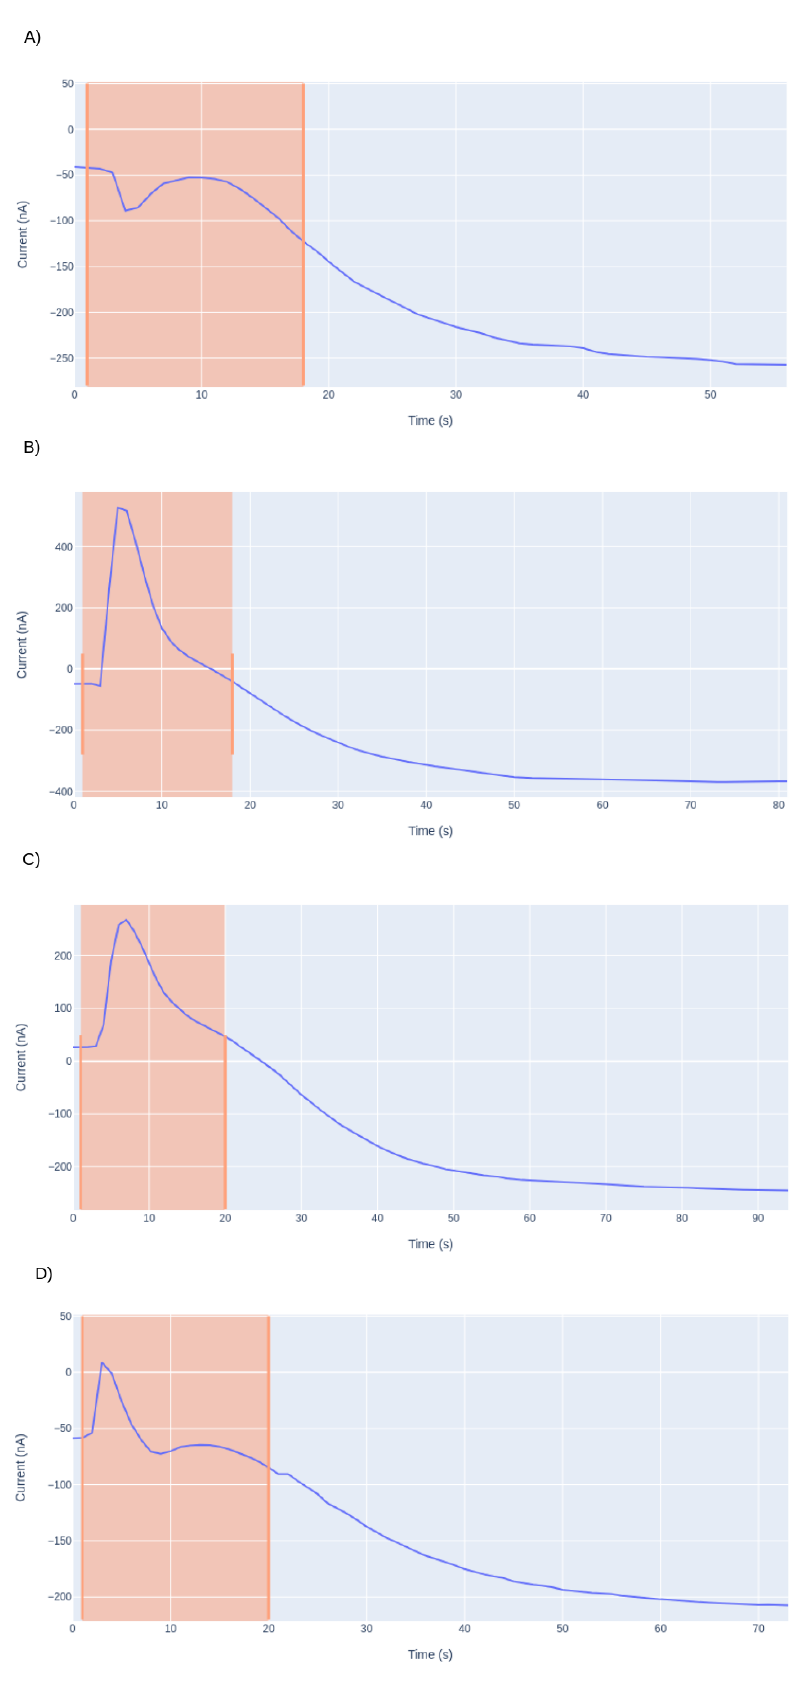
Figure 13. Different amperograms ( A – D ) with different types of behavior observed once the sample is